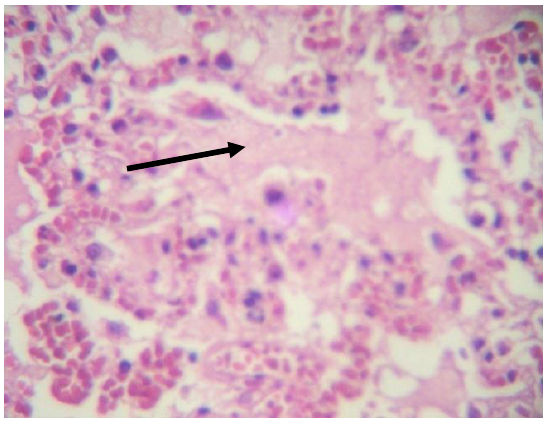
Fig 14: Microscopic section of lung from 2nd immunized group at 3 days post challenge show fibrinous material within edema in lumen of alveoli mm (H&E X20).